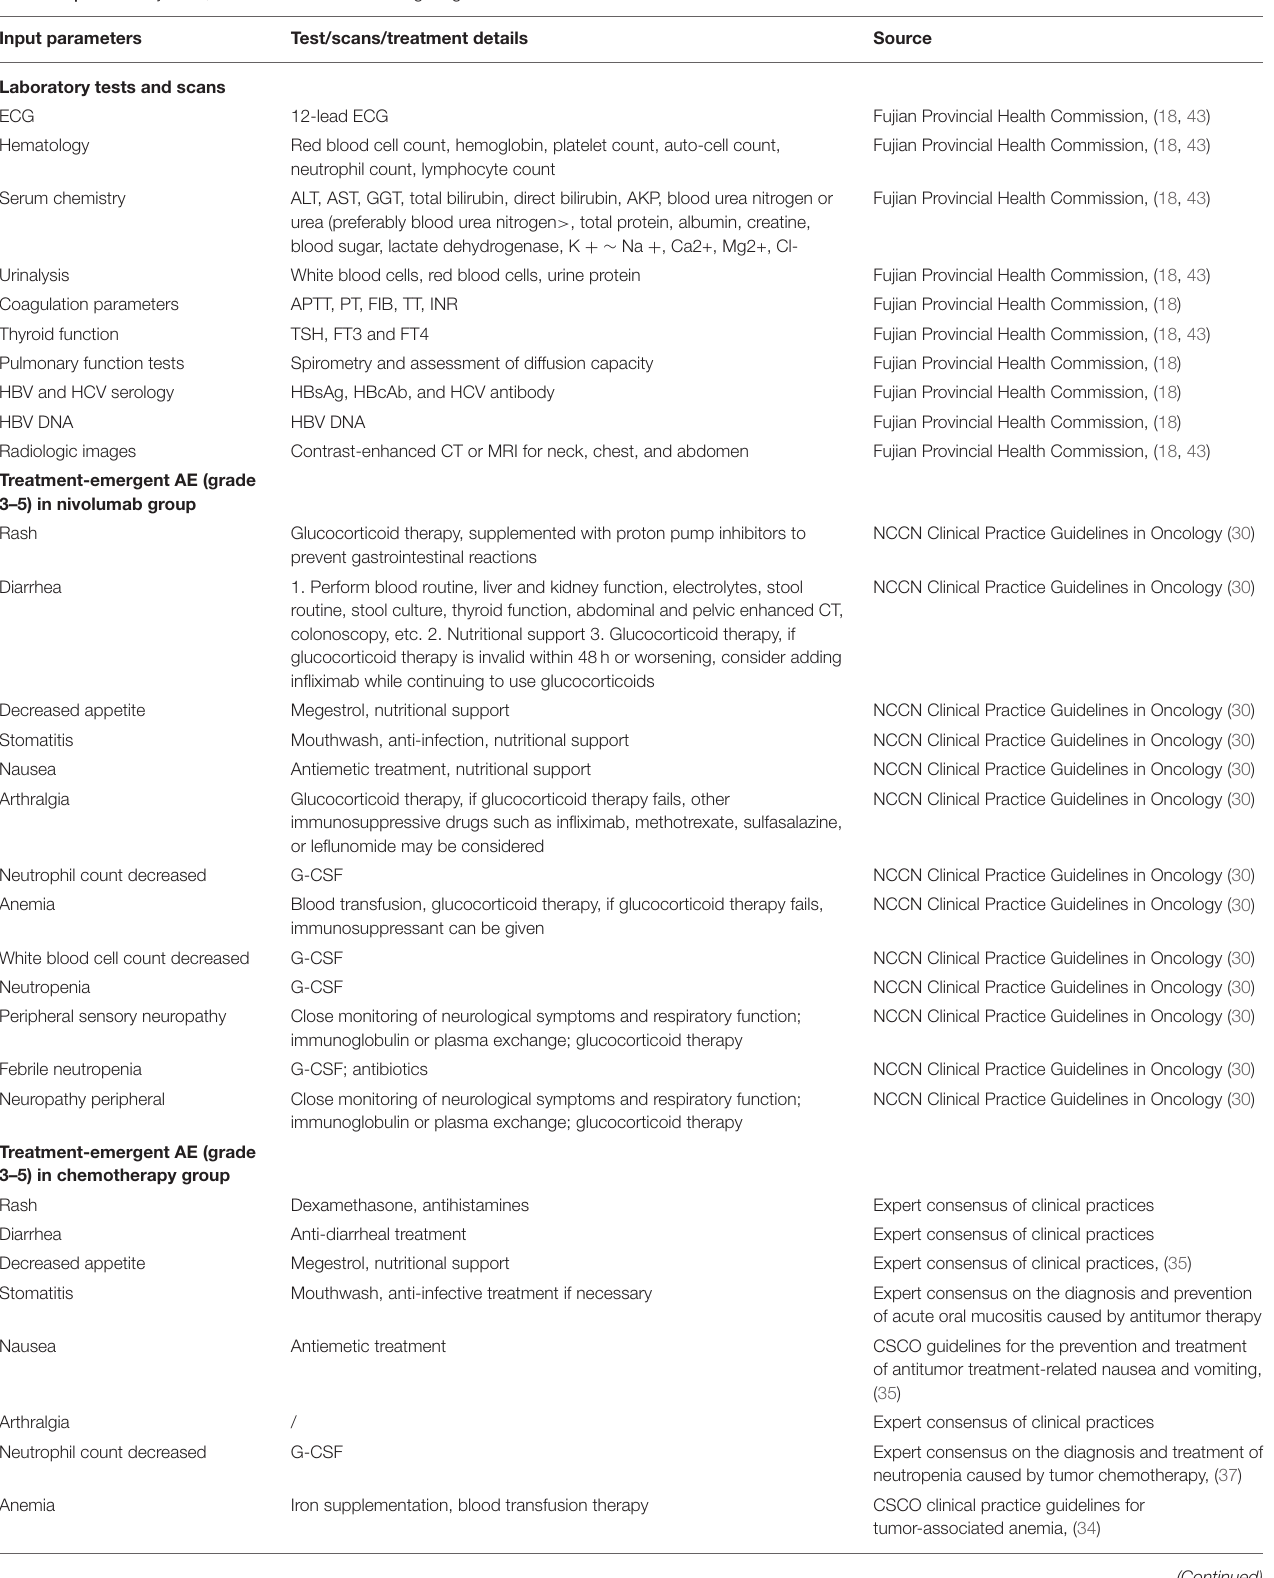
TABLE 2 | Laboratory tests, scans and treatment-emergent grade3–5 AE